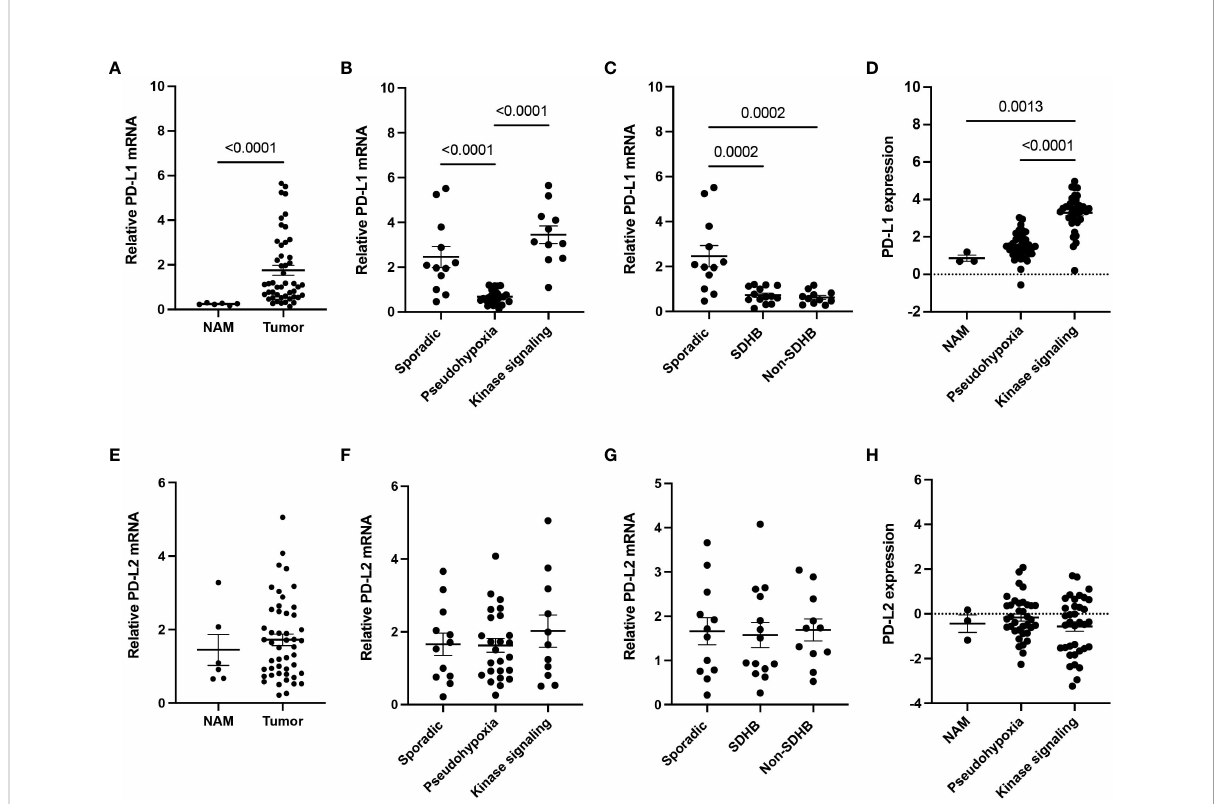
FIGURE 1 PD-L1 and PD-L2 expressions in PPGL cohort. (A) Expression of PD-L1 ( CD274 ) in PPGL tissue compared to normal adrenal medulla (NAM). (B) Expression of PD-L1 in the pseudohypoxia and kinase signaling subtype cluster. (C) Expression of PD-L1 within pseudohypoxia clusters based on SDHB mutation in our representative cohort (non- SDHB group comprises VHL and EPAS1 mutations). (D) Expression of PD-L1 in subtype clusters from TCGA. (E) Expression of PD-L2 ( PDCD1LG2 ) in PPGL tissue compared to normal adrenal medulla (NAM). (F) Expression of PD-L2 in the pseudohypoxia and kinase signaling subtype cluster. (G) Expression of PD-L2 within pseudohypoxia cluster based on SDHB mutation in our representative coho (non- SDHB group comprises VHL and EPAS1 mutations). (H) Expression of PD-L2 in subtype clusters from